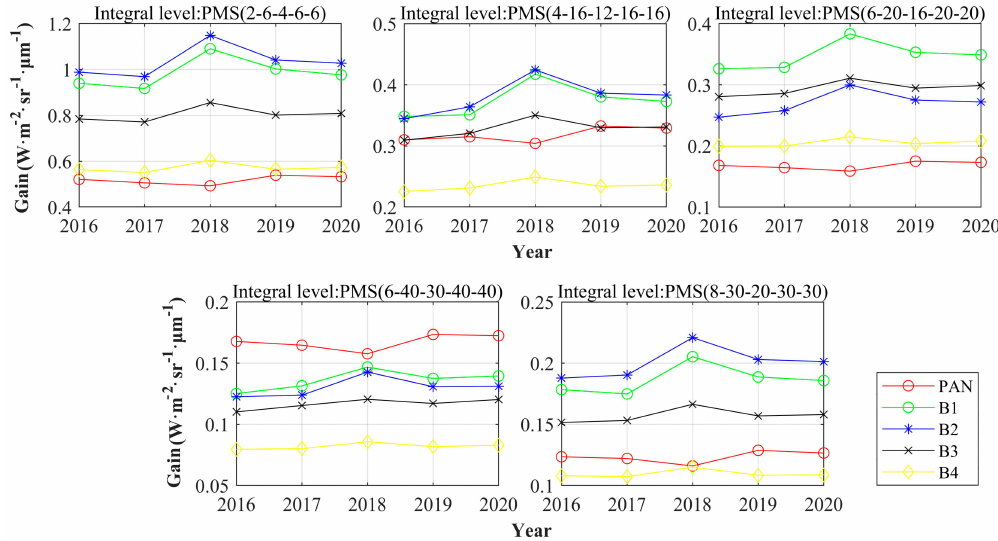
Figure 9. The calibration coefficients from 2016 to